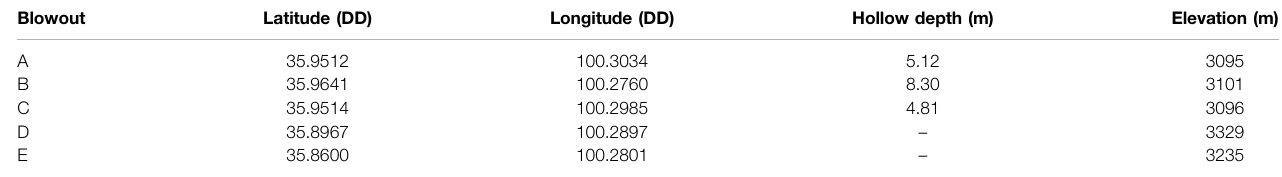
TABLE 1 | Location of the studied blowout features (centroid of the erosional